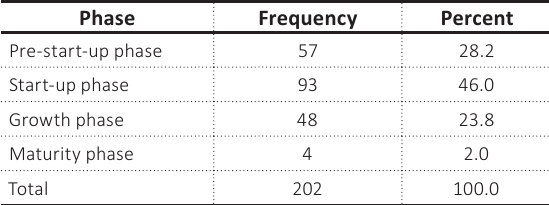
Table 2. Life-cycle